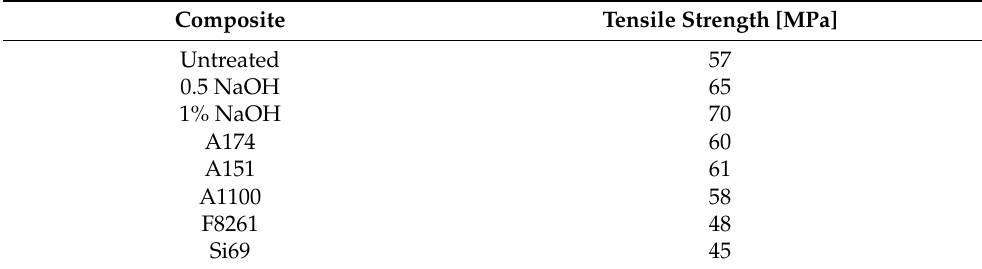
Table 5. Influence on tensile strength of untreated and different chemical-treated banana fibre- reinforced polyester composite